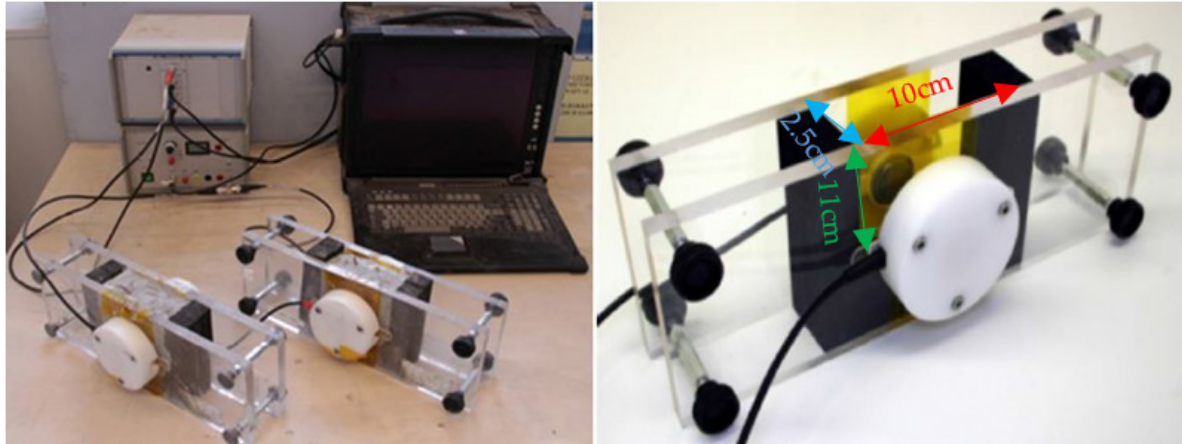
Figure 1. FreshCON system [63] for measuring the ultrasonic pulse velocity.